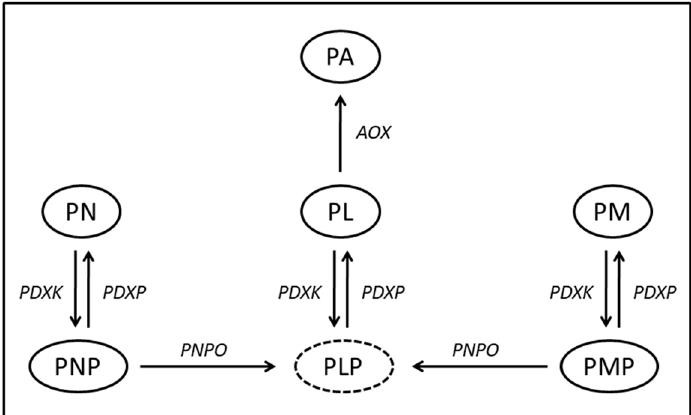
Figure 1. Schematic display of vitamin B6 metabolism. The different B6 vitamers pyridoxine (PN), pyridoxamine (PM), pyridoxal (PL) and their respective phosphate-esters (PNP, PMP and PLP) are interconvertible through the action of several enzymes. Pyridoxic acid (PA) is the main degradation product of vitamin B6. PDXK = pyridoxal kinase. PDXP = pyridoxal phosphatase. PNPO = pyridox(am)ine oxidase. AOX = aldehyde oxidase.